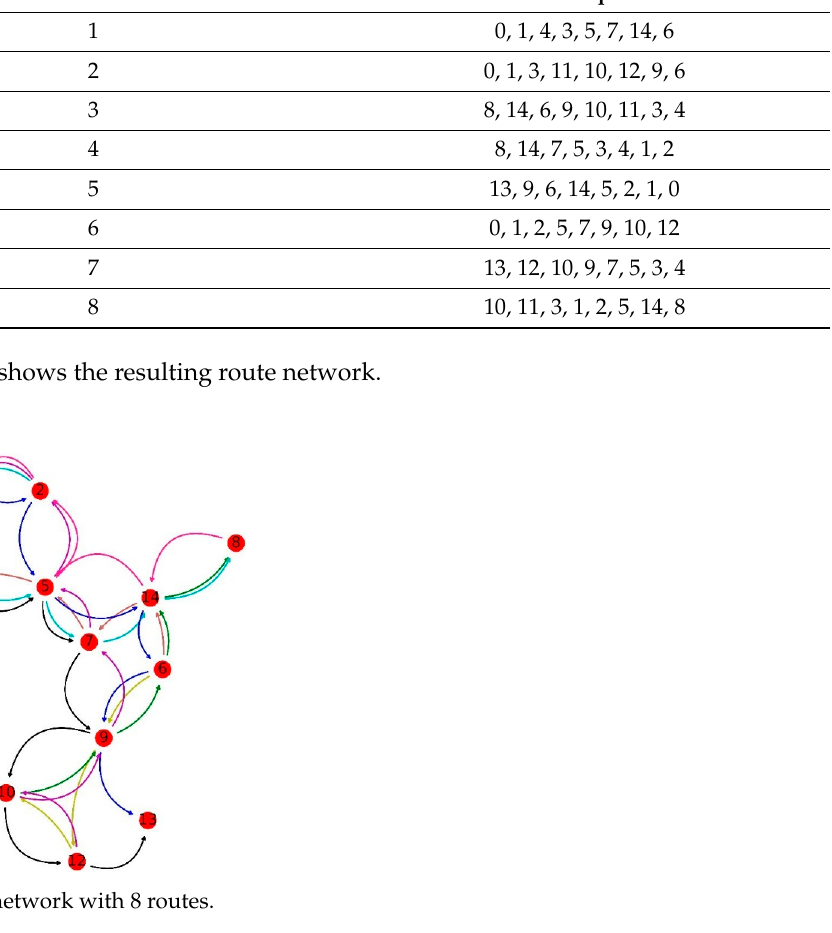
Table 8. Best Route Set for 8-Route Case.